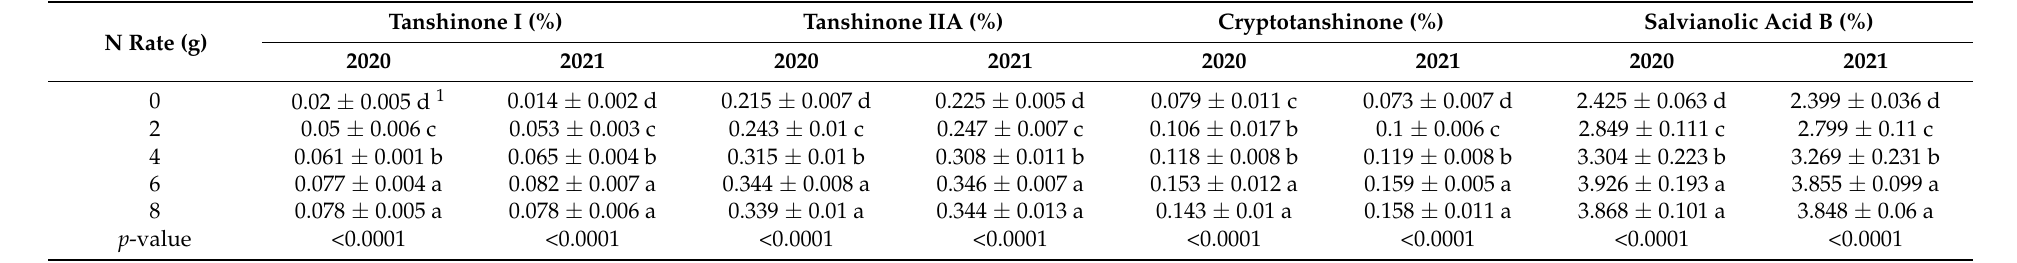
Table 5. Content of tanshinone I, tanshinone IIA, cryptotanshinone, and salvianolic acid B in roots of plants receiving five N rates in 2020 and